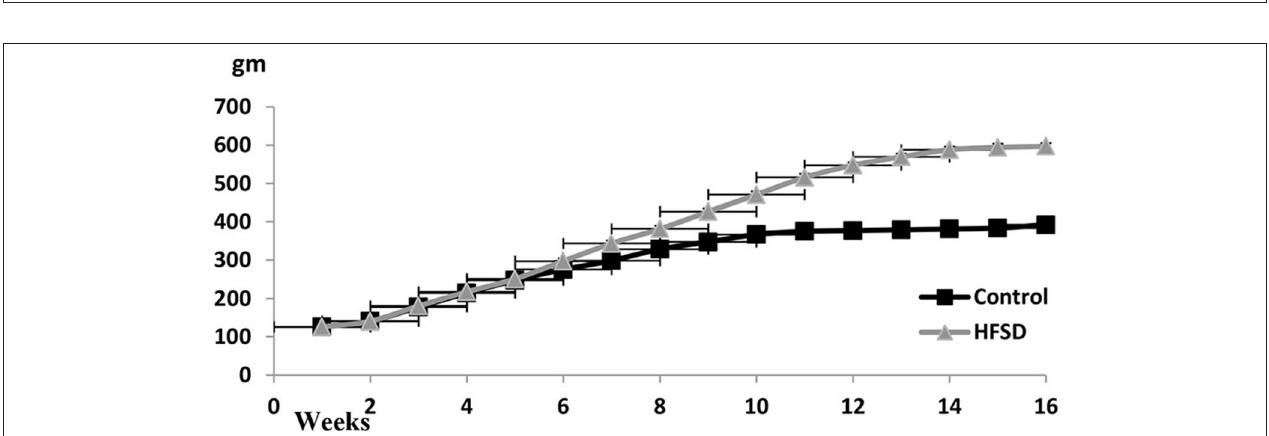
FIGURE 2 | Body weights (gm ± SEM) of Wistar rats from the beginning of the experiment until the 16th week. The prediabetic rat was determined on the 9th week and the diabetic determined on the 16th week. HFHSD: high-fat high sugar diet.